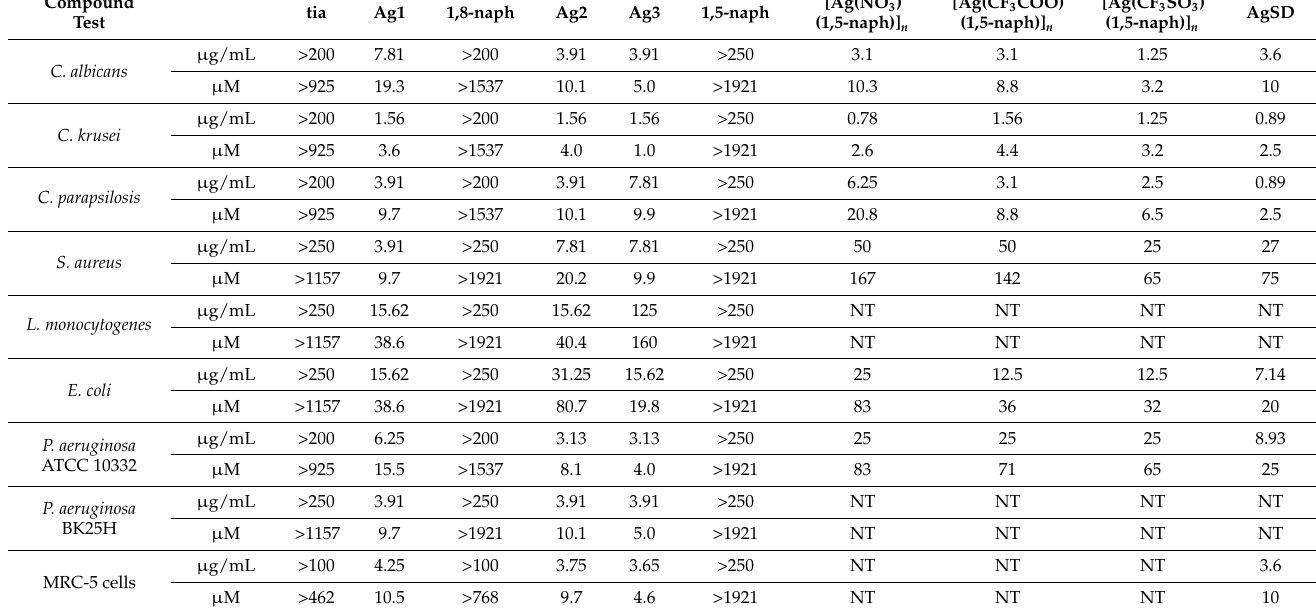
Table 4. Minimum inhibitory concentrations (MIC, µ g/mL and µ M) and cytotoxicity against healthy human fibroblasts MRC-5 (IC 50 , µ g/mL and µ M) of Ag1 – 3 complexes and ligands against fungal and bacterial strains. Silver(I) complexes with 1,5-naphthyridine (1,5-naph) and silver(I) sulfadiazine (AgSD) were given for comparative purposes [30,31]. NT = Non tested. Reproduced with permissions from refs. [30,31]. Copyright (2019)